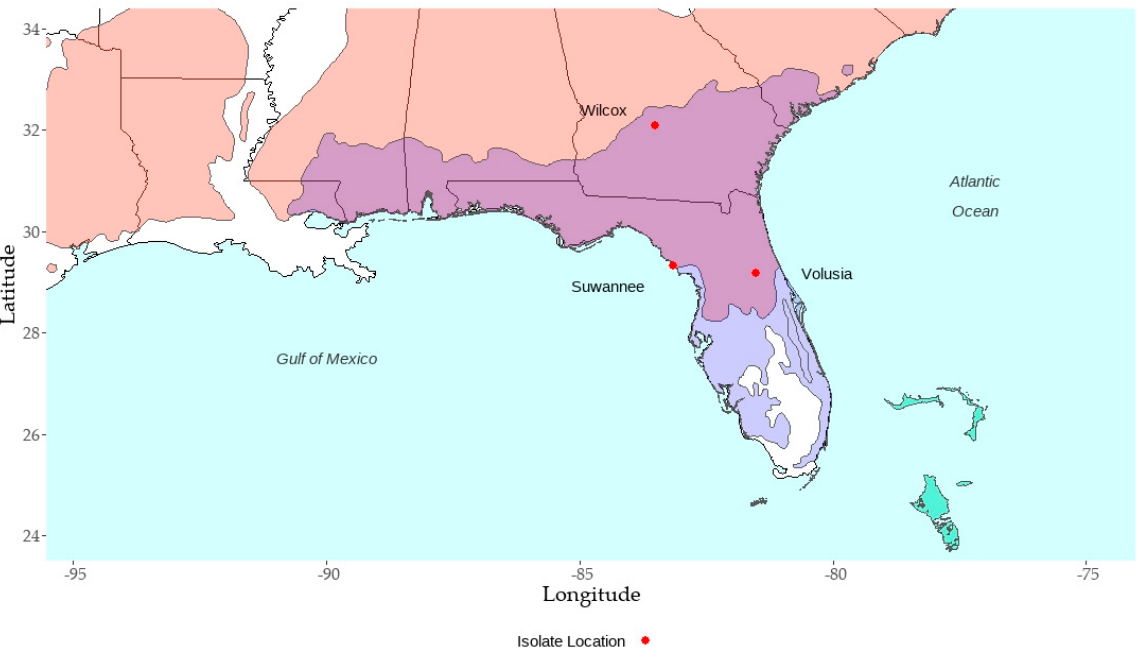
Figure 6. Map of isolate collection locations overlaid on a map of the natural range of P. caribaea (light green, P. taeda (salmon, light purple zone overlapping with slash pine), and P. elliottii var. elliottii (overlapping light purple zone and lilac). Note that Wilcox, the northern-most isolate was demonstrated to be the most pathogenic for loblolly pine.